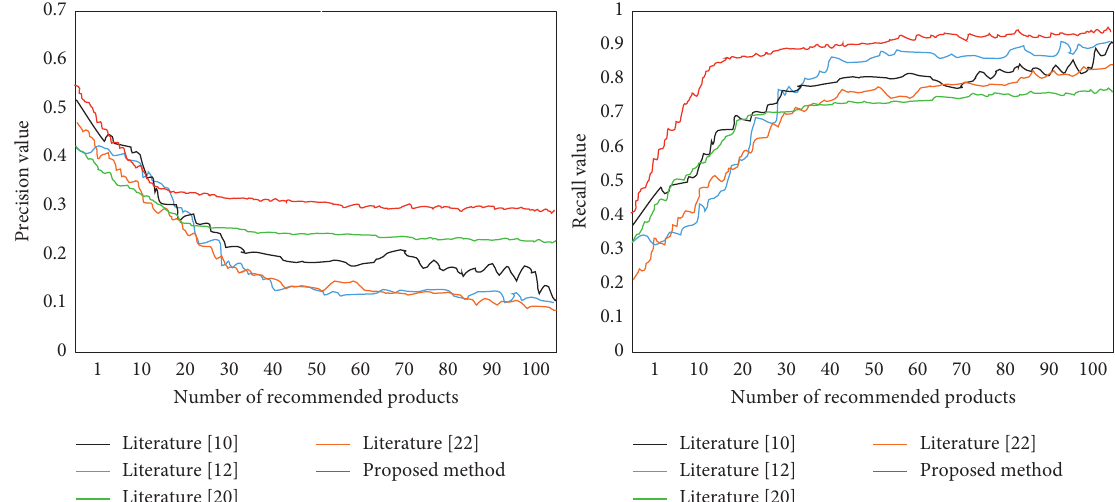
Figure 8: Analysis of the results of different algorithms and this